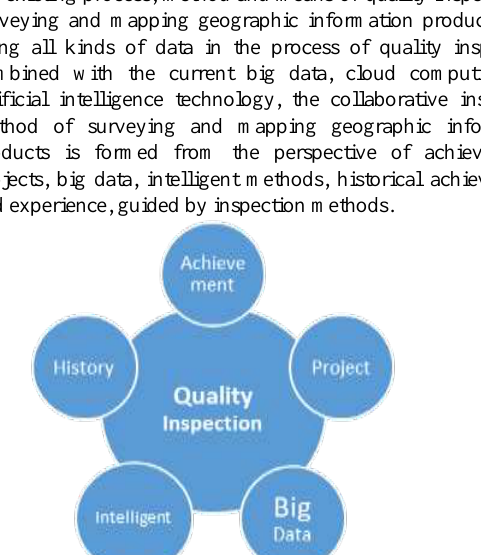
Figure 1 . Multi-Dimensional Synergy.